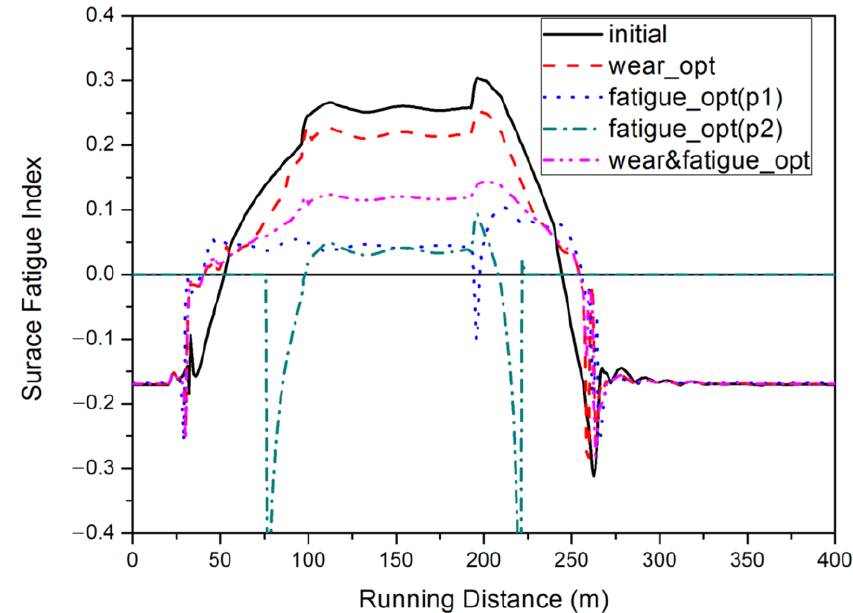
Figure 14. Surface fatigue index of wheel.